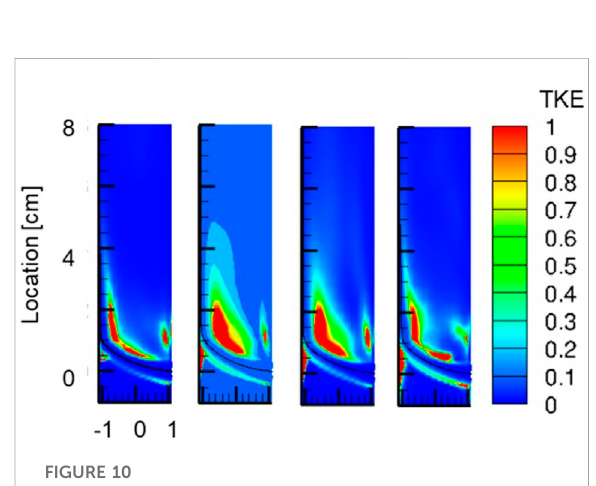
FIGURE 10 TKE in the simulations using different turbulence models (from left to right: EBRSM, LS k- ε and k- ω SST,